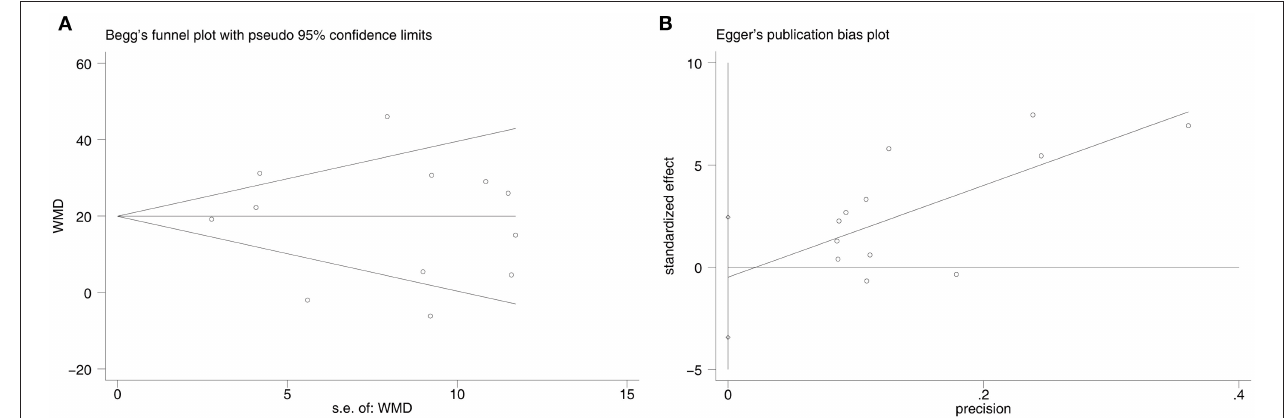
FIGURE 5 | Publication bias of included studies. (A) : the Begg’s test, (B) : the Egger’s